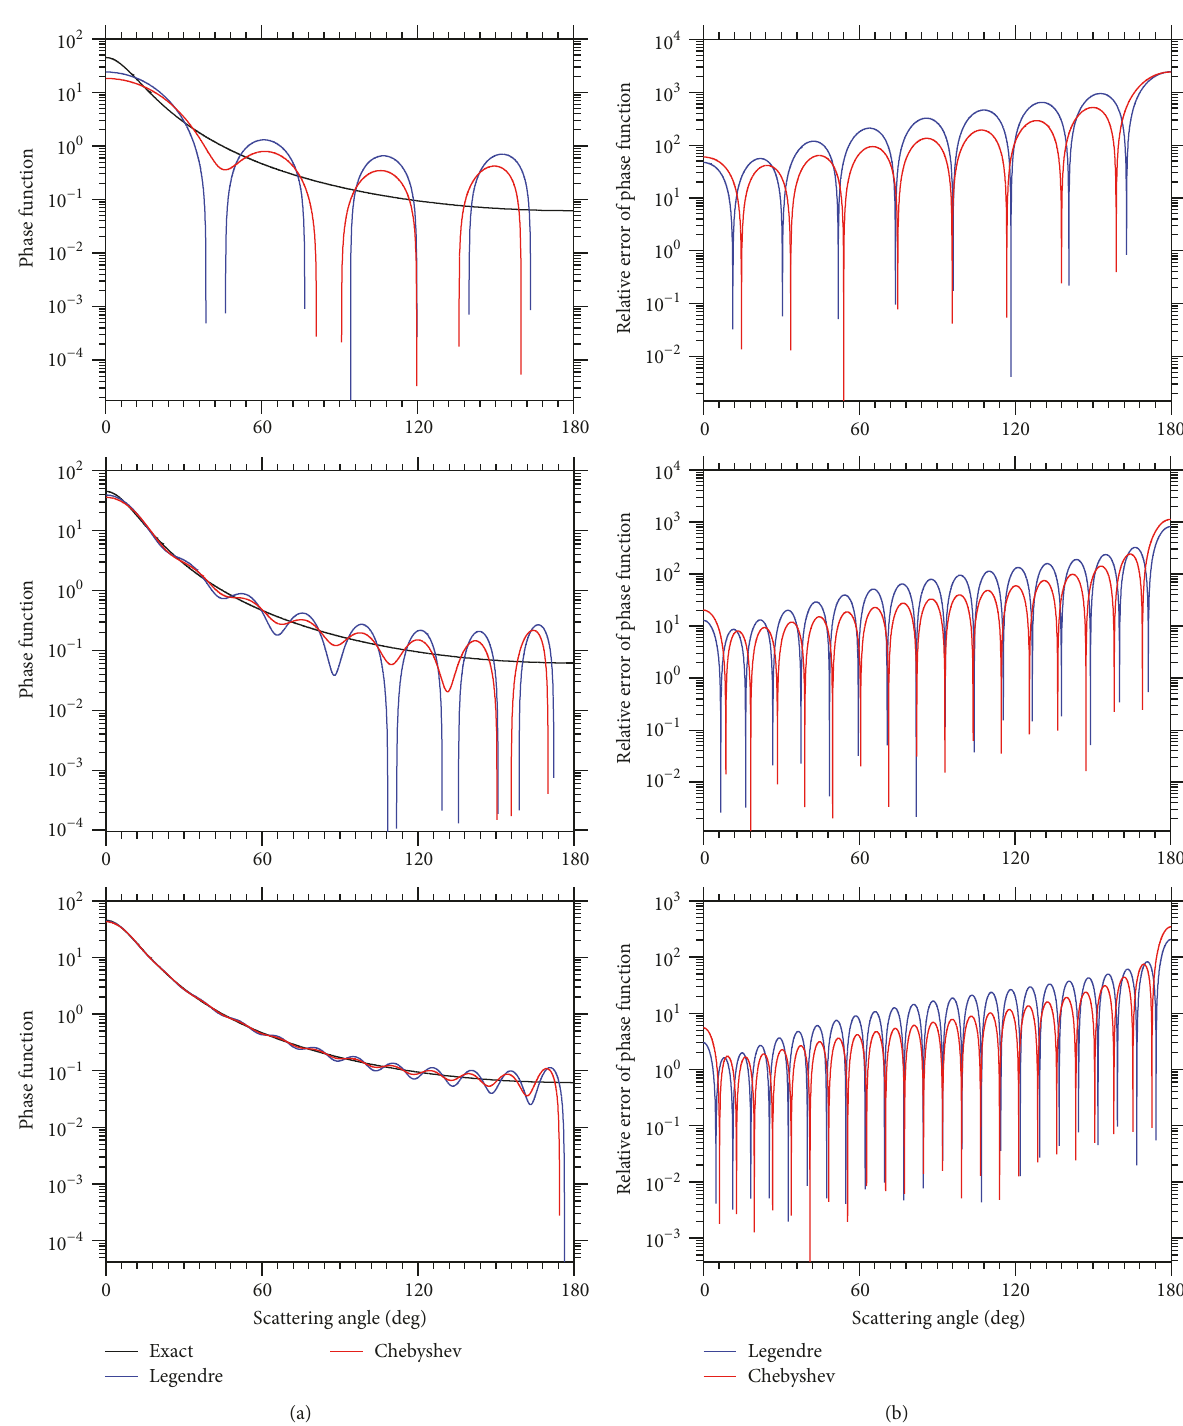
Figure 1: HG phase function (a) with 𝑔 = 0.8 and relative error of phase function (b) in 8, 16, and 24